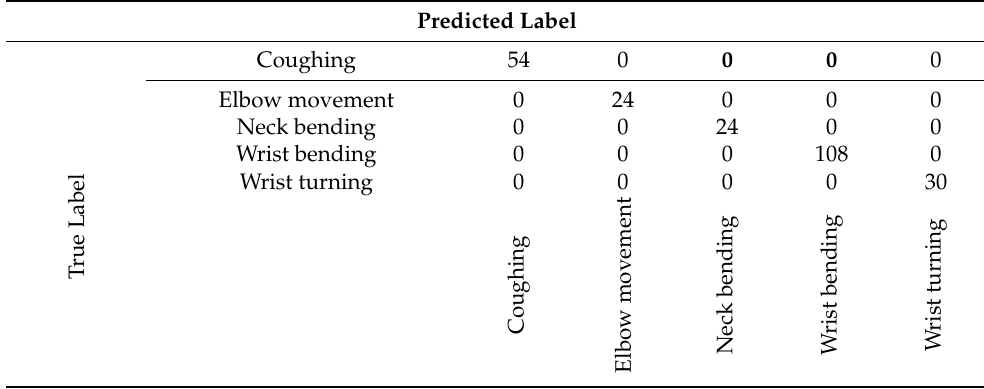
Table 7. Confusion matrix obtained with K-mer-based RF (number of cuts = 60 and subsequence length = 2).